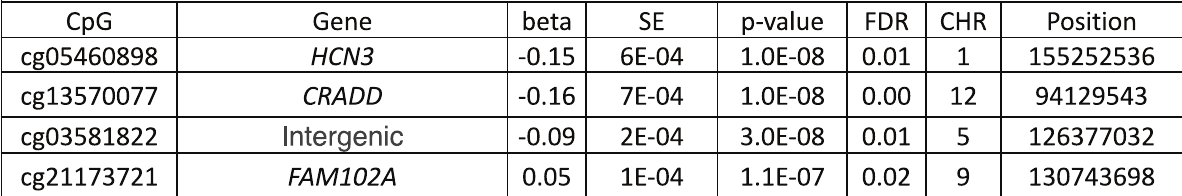
Translational Psychiatry (2022)